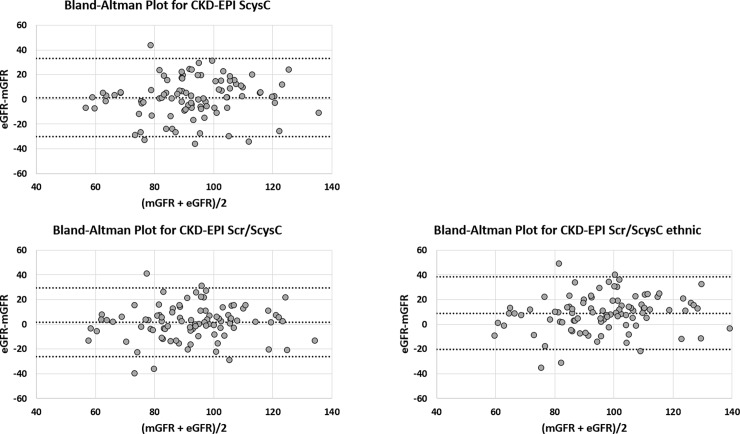
Bland and Altman analysis between mGFR and cystatin C-based and combined equations (with and without the ethnic factor).All values are expressed in mL/min/1.73m2. CKD-EPI SCys CKD-EPI equation based on cystatin C only; CKD-EPI SCrCys: CKD-EPI combining creatinine and cystatin C with ethnic factor. CKD-EPI SCrCys nef: CKD-EPI combining serum creatinine and cystatin C without ethnic factor. The central line represents the mean difference between measured and estimated GFR, whereas the upper and lower lines represent the limits of agreement (mean difference ± 2SD).